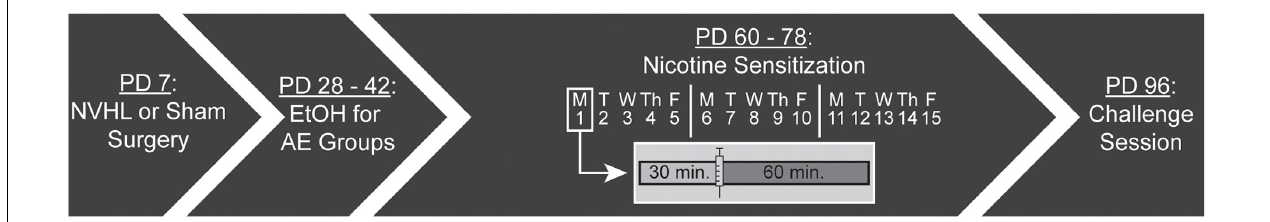
FIGURE 1 | Experimental timeline. NVHL or sham surgery was performed on postnatal day (PD) 7. Half of each group received access to 10% ethanol (EtOH) in their home cage from PD 28–42. Nicotine sensitization began on PD 60 and occurred Monday through Friday for three consecutive weeks (15 sessions). Each session had a 30 min preinjection phase before the rat received a subcutaneous injection of 0.5 mg/kg nicotine followed by a 60 min postinjection phase. After a 2 week washout, all rats had a challenge session on PD 96.